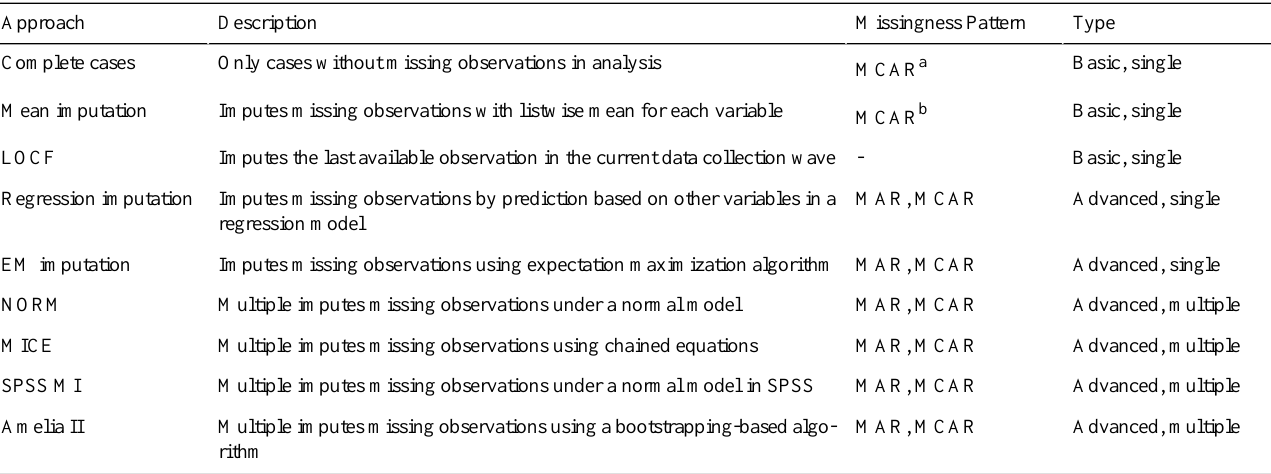
Table 1. Missing data approaches in this